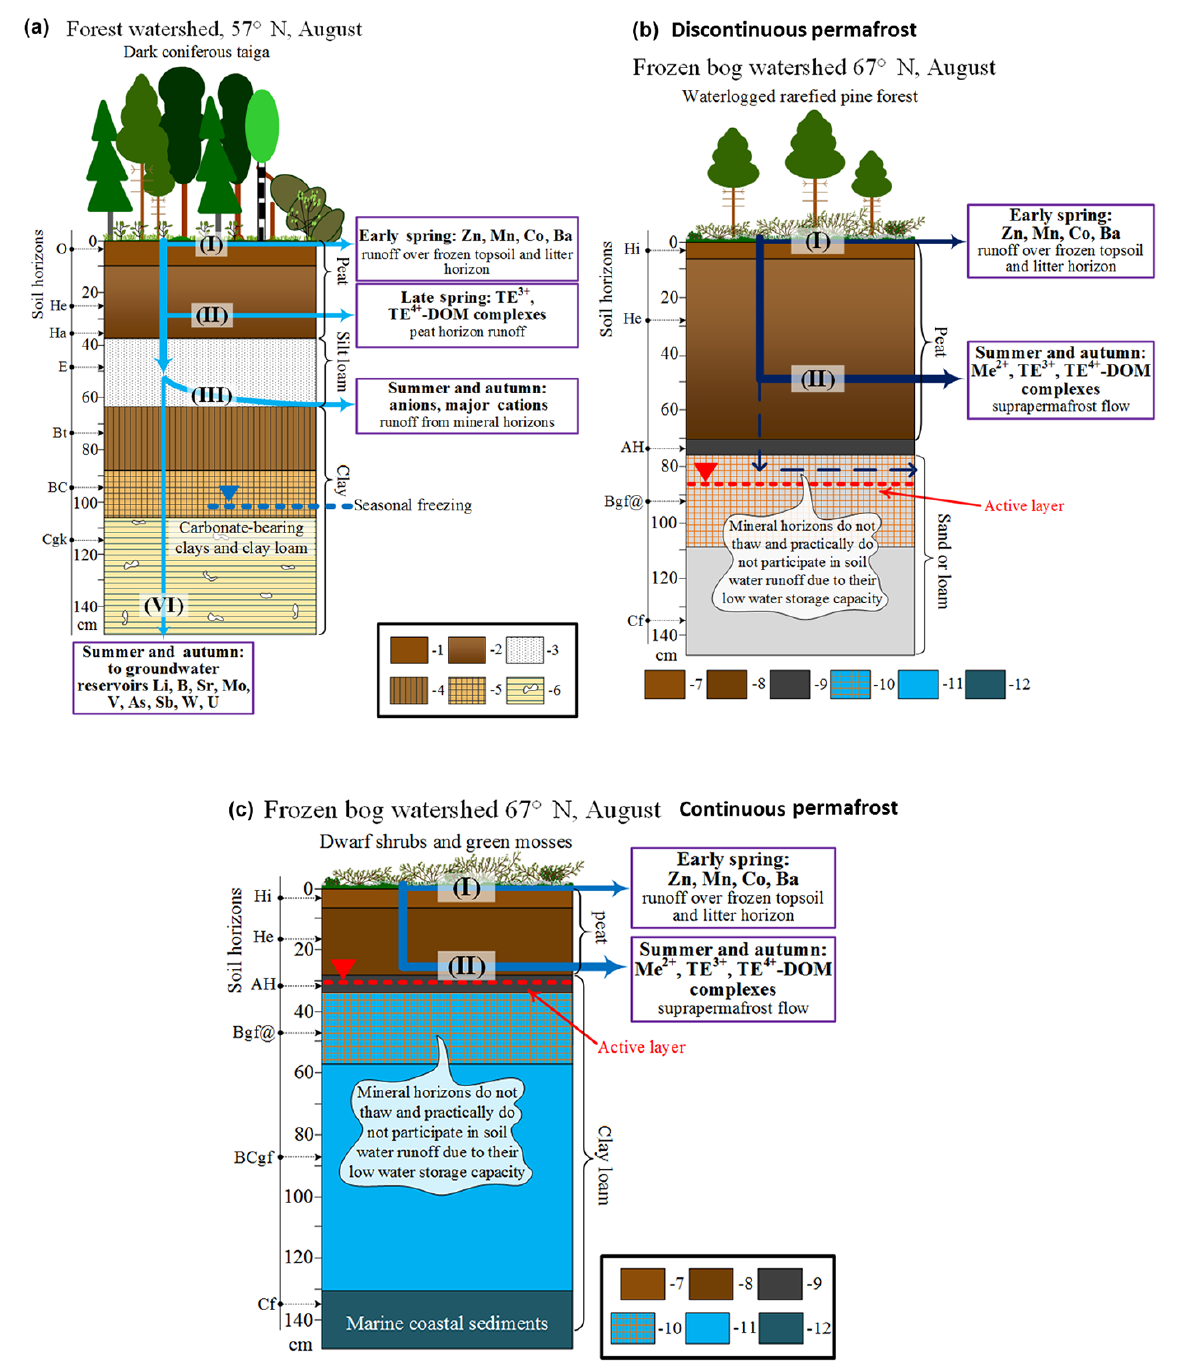
Figure 12. Scheme of TE pathways within the soil profile and to the river. ( a ) In a forest watershed of the south, permafrost-free zone (57 ◦ N) and ( b ) a discontinuous permafrost forest–tundra zone. Soil horizons (FAO, 2006): 1, O (Mor, forest litter); 2, medium-decomposed peat (He) transforming into strongly decomposed peat (Ha) in the bottom layer; 3, mollic humic horizon (a) ; 4, ABg surface horizons with stagnic properties; 5, Bg middle stagnic horizon; 6, Cgk carbonate-bearing clays and clay loam. (c) TE pathways in frozen bog peatlands of continuous permafrost (67 ◦ N). Soil horizons (FAO, 2006): 7, weakly decomposed peat (Hi); 8, partially decomposed peat (He); 9, humic horizons (AH); 10, cryoturbated frozen stagnic horizon (Bgf); 11, frozen stagnic horizon (BC˜gf); 12, sedimentary deposits (Cf). In the south, Me 2 + –DOM complexes are retained by clay, and deep in the soil profile by clay loam with carbonates. In the north, the active layer depth does not exceed the overall thickness of the peat and thus the leachates of ground vegetation and peat layer do not meet mineral horizons during their transit to the